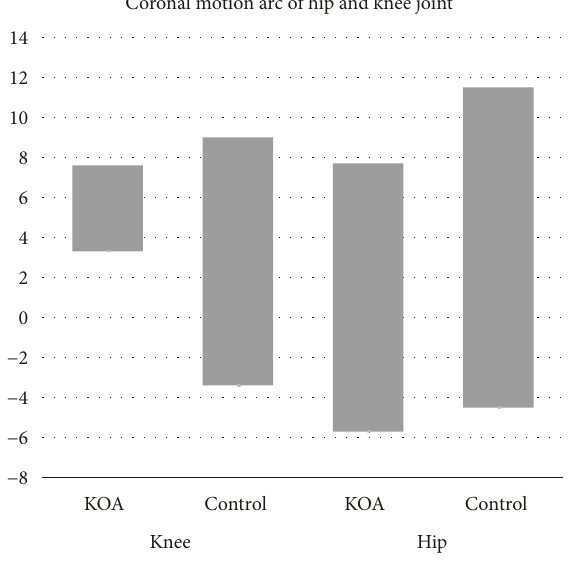
Figure 3: Coronal motion arcs of the hip and knee joints. The KOA group showed smaller coronal motion arcs compared to the control group.Negativevaluesindicatevalgusandabductioninthekneeand hip joints, respectively. There was a significant correlation between the hip and knee